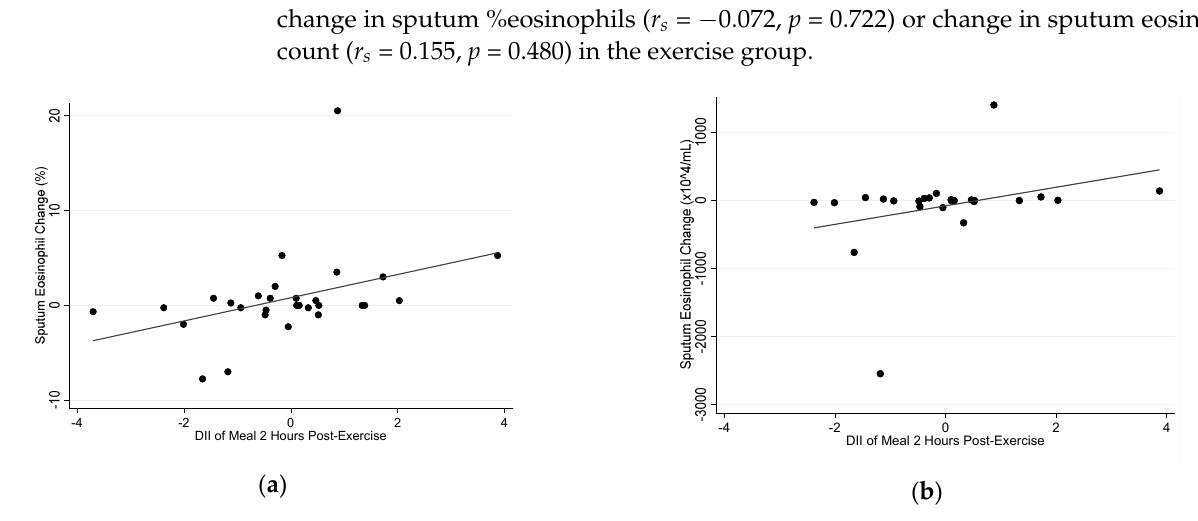
Figure 3. Correlation between the E ‐ DII of the meal consumed two hours post ‐ exercise with ( a ) sputum %eosinophil change at four hours ( r s = 0.478, p = 0.008), and ( b ) sputum eosinophil count change at four hours ( r s = 0.425, p = 0.030), following an acute bout of moderate–vigorous aerobic exercise.